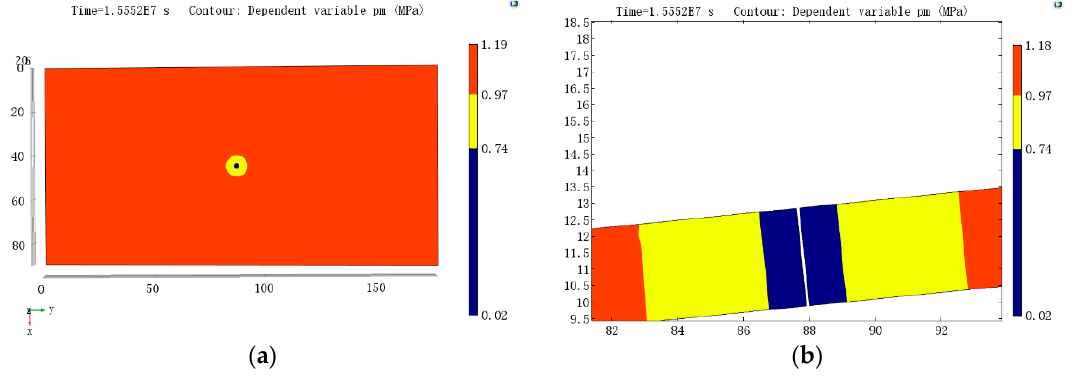
Figure 5. The effective drainage radius and influence radius of a single borehole: ( a ) inclined plane, ( b ) tangent plane.